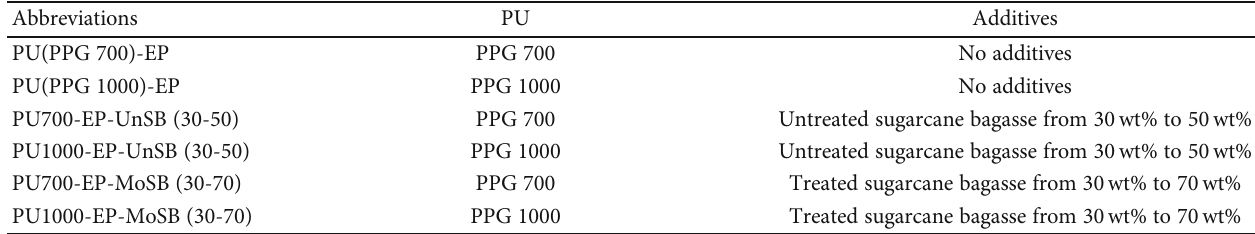
Figure 1: FTIR spectrum of PU-modi fi ed epoxy synthesis over reaction time. Table 1: The composition of each specimen and its